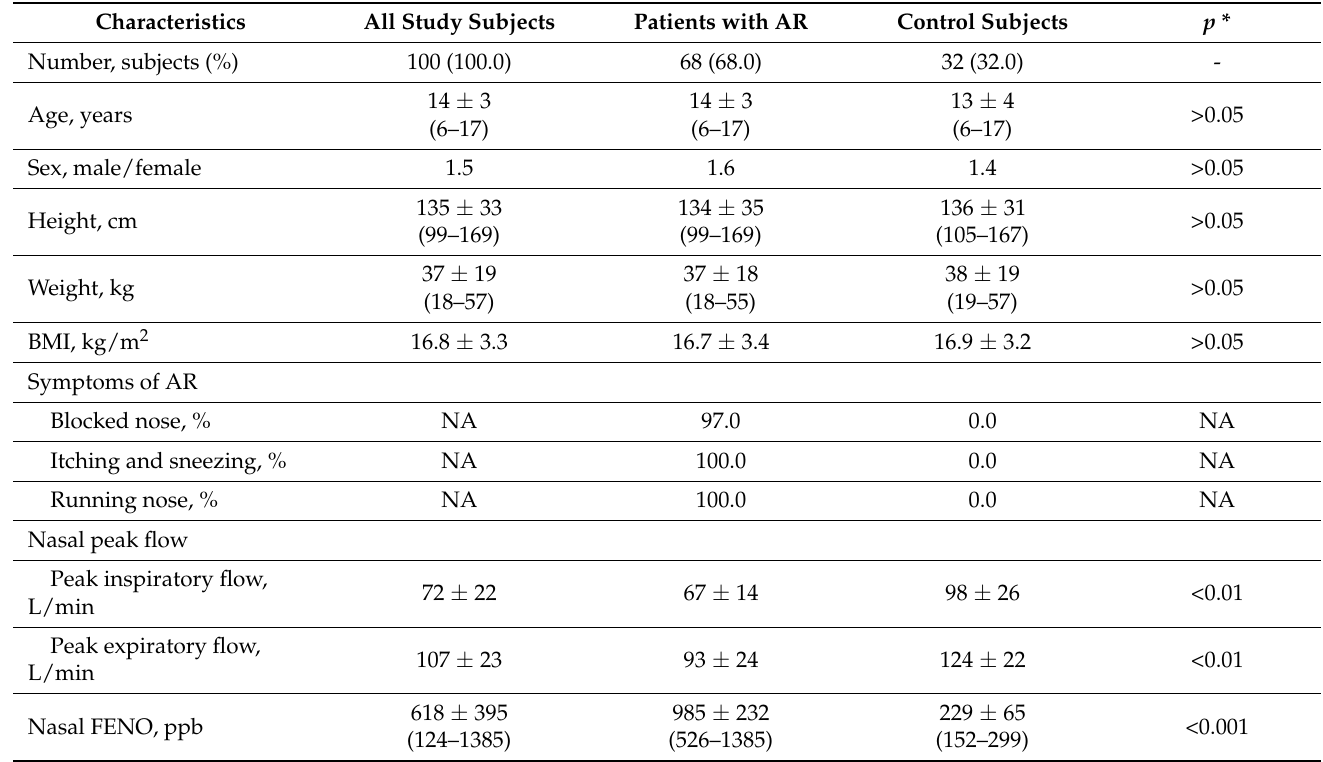
Table 1. Clinical and functional characteristics of study